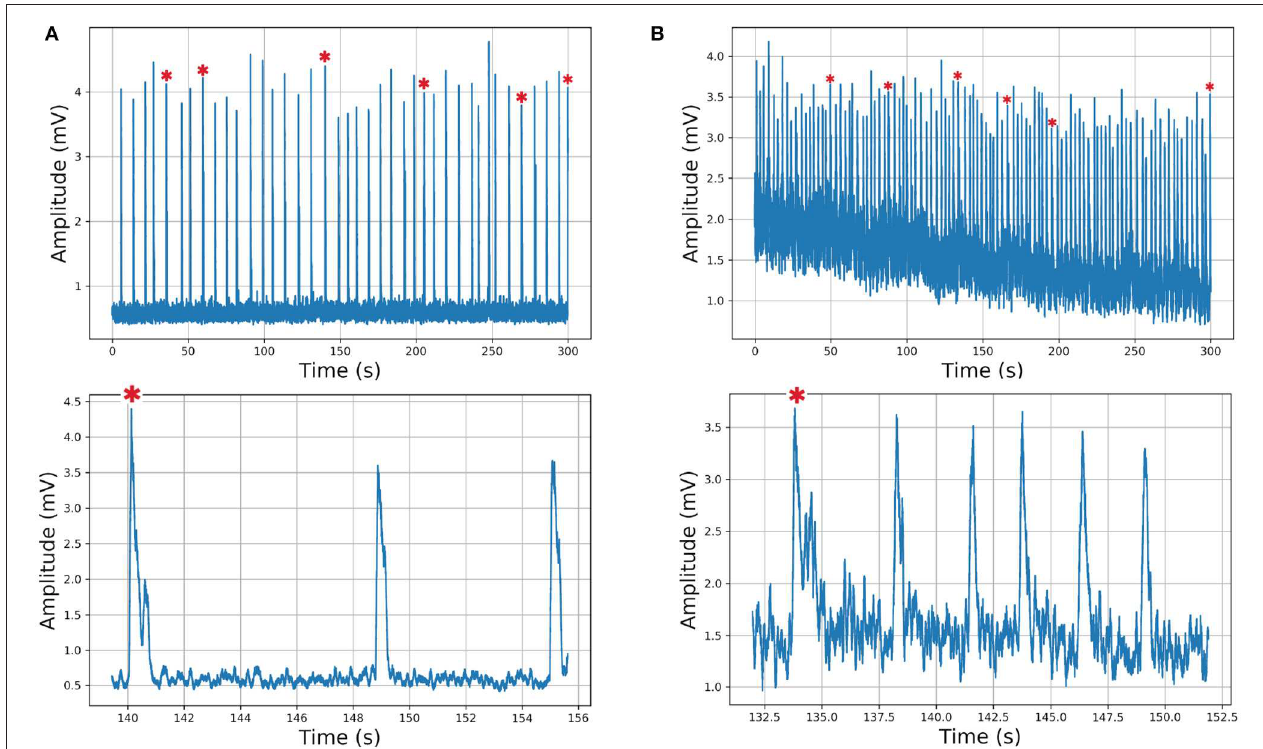
FIGURE 8 | Respiratory rhythm recording and corresponding visibility graphs for (A) control with 39 and (B) bombesin with 99 inspiration burst. In asterisk (*) are shown sighs.